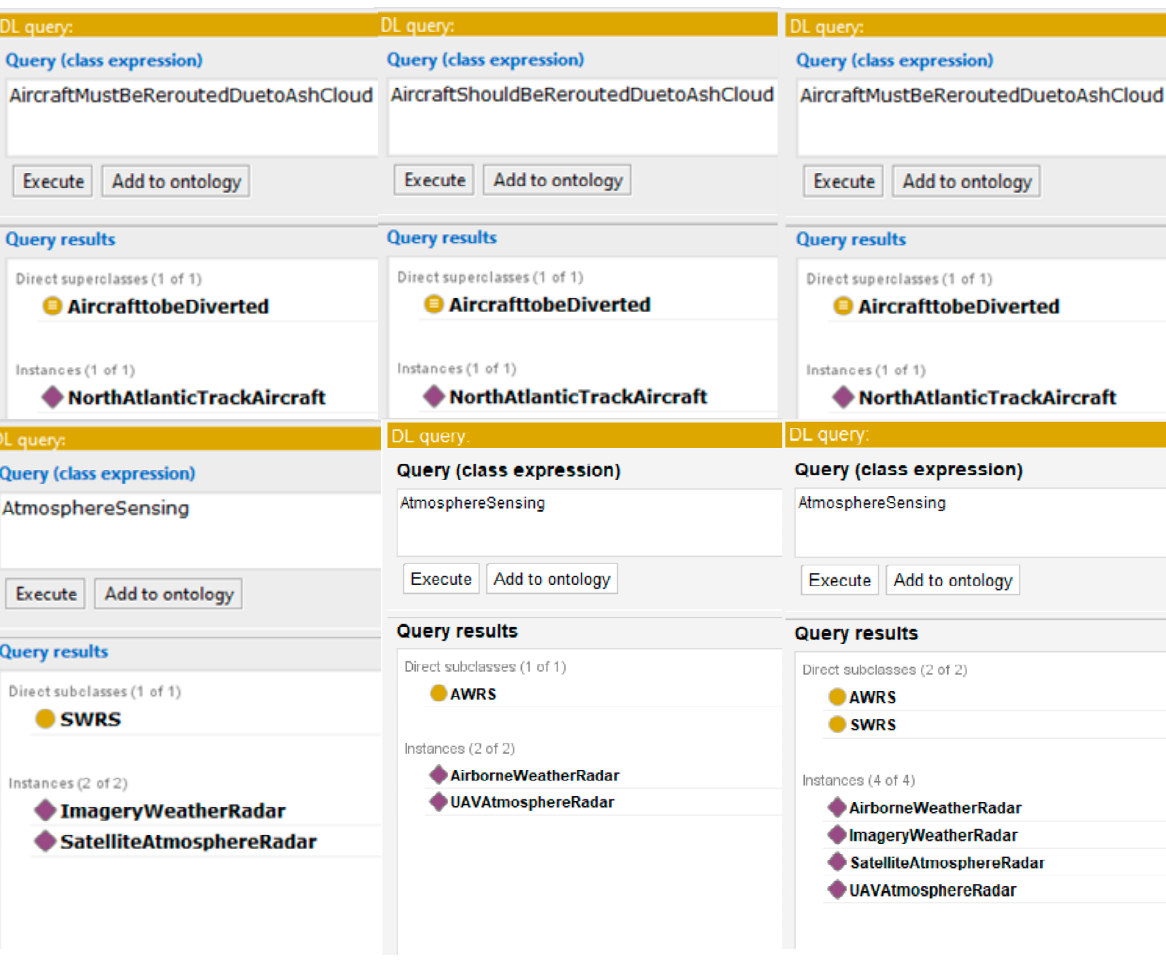
Figure 18. Querying results to assess airspace situation in Scenario 2.